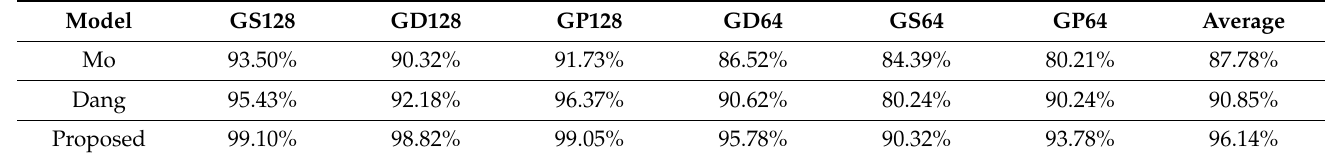
Table 5. Comparison of the results of different models.